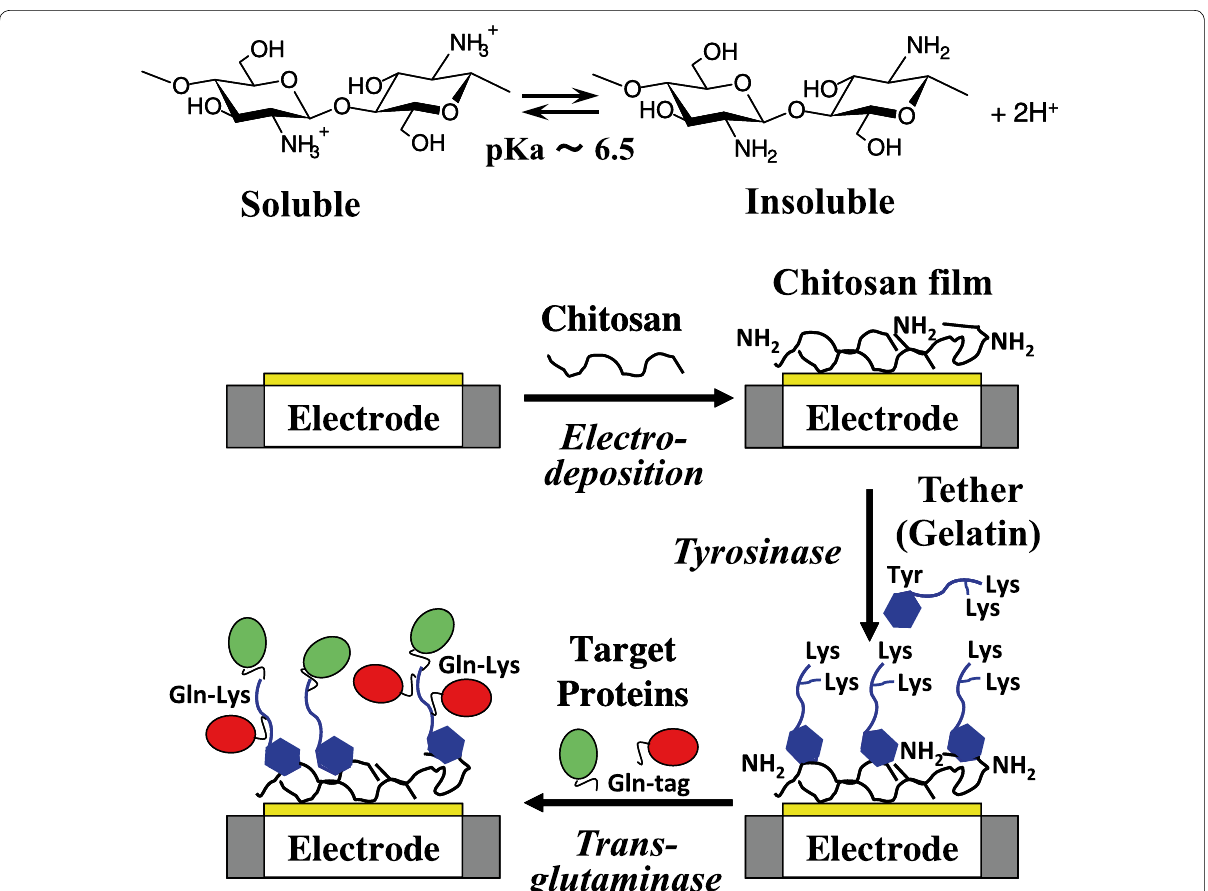
Fig. 8 Biofabrication for construction of nanodevices. Schematic of the procedure for orthogonal enzymatic assembly using tyrosinase to anchor the gelatin tether to chitosan and microbial transglutaminase to conjugate target proteins to the tether (Figure adapted with permission from: Ref. [83]. Copyright (2009) American Chemical